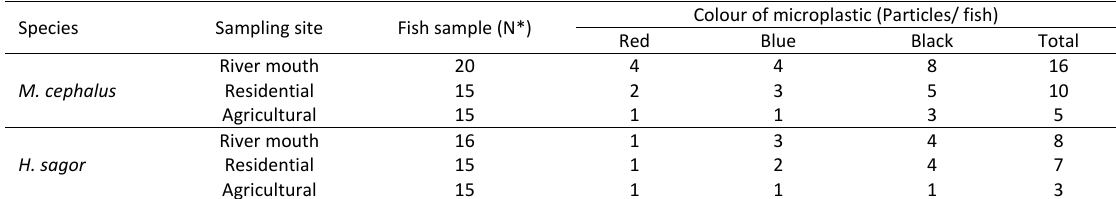
Table 2: The average abundance of microplastic at the alimentary tract of mullet Mugil cephalus and bagok catfish Hexanematichthys sagor according to the location and colour of microplastics. Species